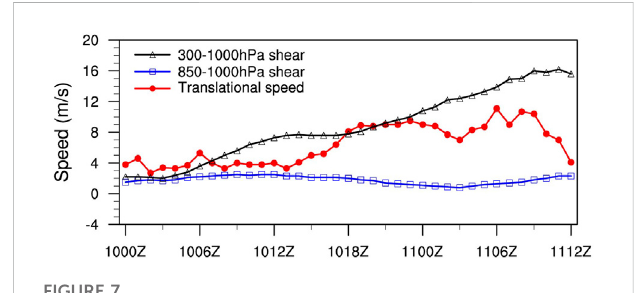
FIGURE 7 Time series of deep-layer vertical wind shear between 300 and 1,000 hPa (black line with triangles), low-level shear between 850 and 1,000 hPa (blue line with squares) within a radius of 500 km from the typhoon center, and translational speed of Lekima (red line with fi lled circles) from 0000 UTC 10 August to 1200 UTC 11 August, 2019, from the D02 simulation (unit: m/s).